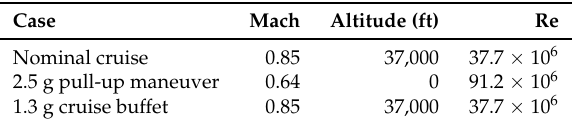
Table 5. Flow conditions for high-fidelity